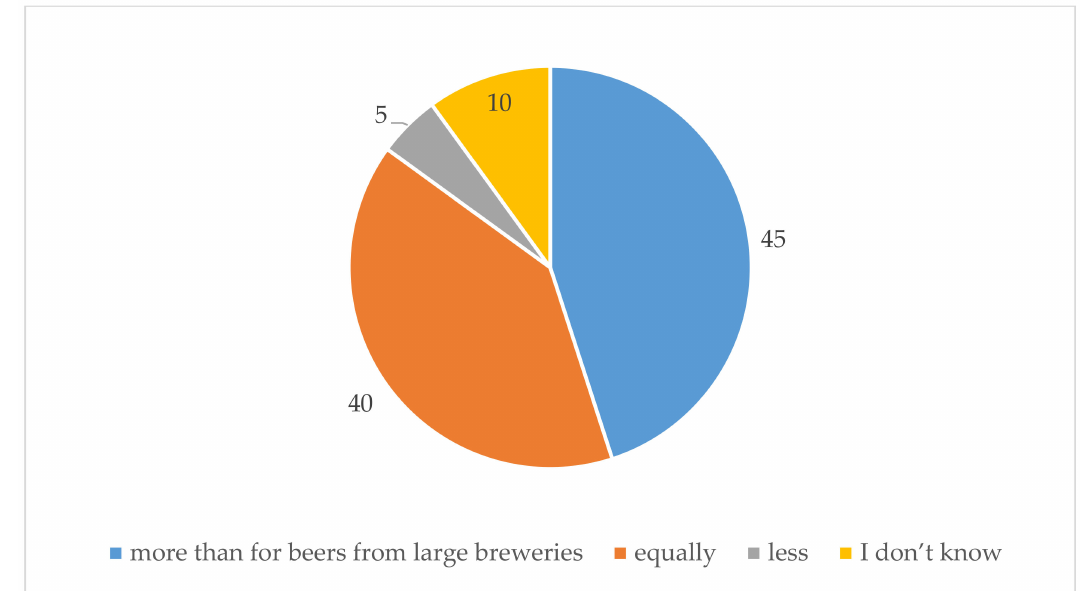
Figure 7. The amount of acceptance of prices for beer from microbreweries in 2017 (in % of respondents—adult citizens of Czechia)